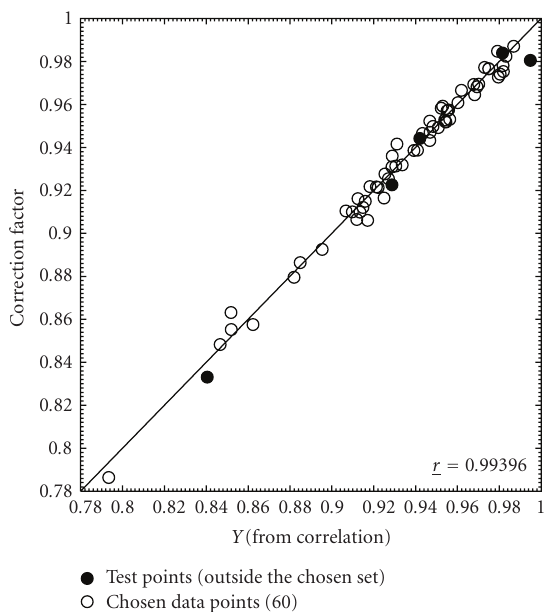
Figure 14: Comparison of actual versus correlated